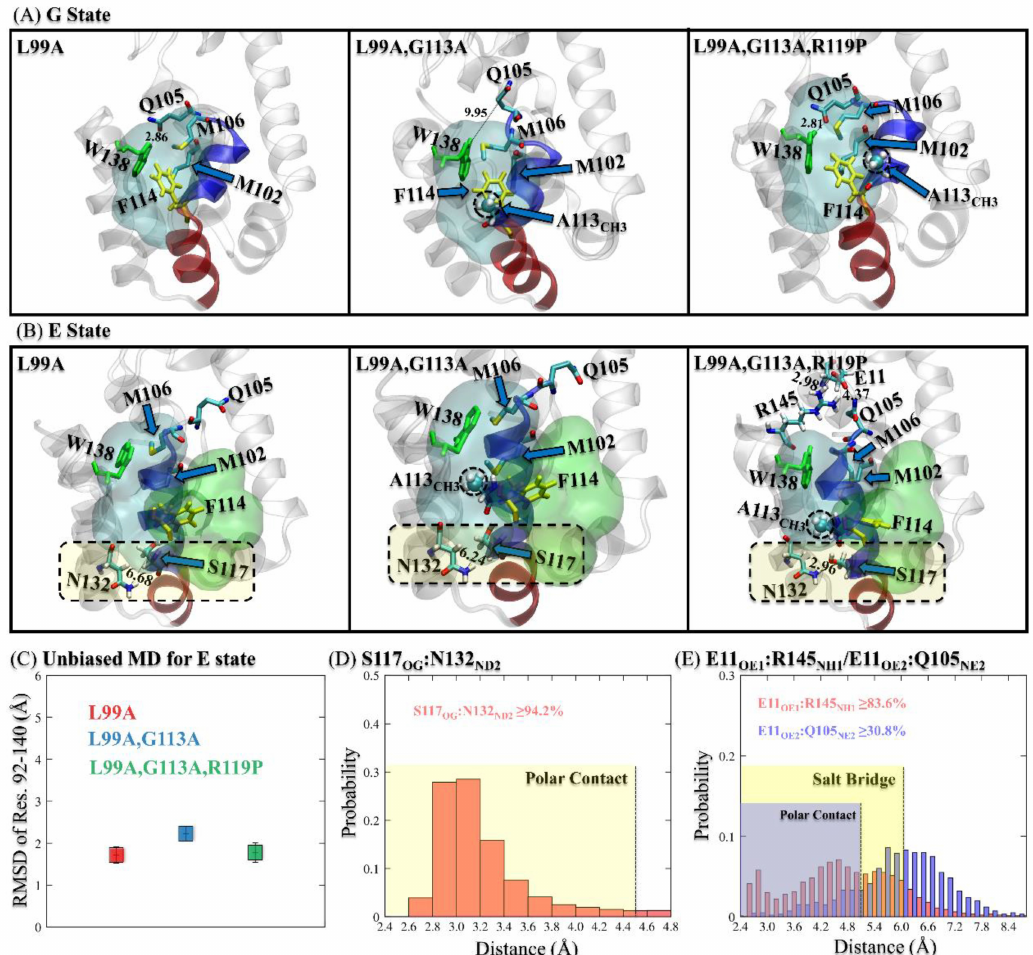
Figure 3. ( A , B ) The detailed structures of the G states ( A ) and the E states ( B ) for the T4L-L99A, the T4L-L99A,G113A, and the T4L-L99A,G113A,R119P variants, with the newly found salt bridges and H-bonds highlighted. ( C ) The average RMSDs of the heavy atoms of residues 90–140 for T4L-L99A (red square), T4L-L99A,G113A (blue square), and T4L-L99A,G113A,R119P (green square) in the 1 µ s conventional MD simulations of the E states. ( D , E ) The probability distributions of the distances between the groups of the residues that form the polar contact S117 OG :N132 ND2 ( D ), the salt bridge E11 OE1 :R145 NH1 and the polar contact E11 OE2 :Q105 NE2 ( E